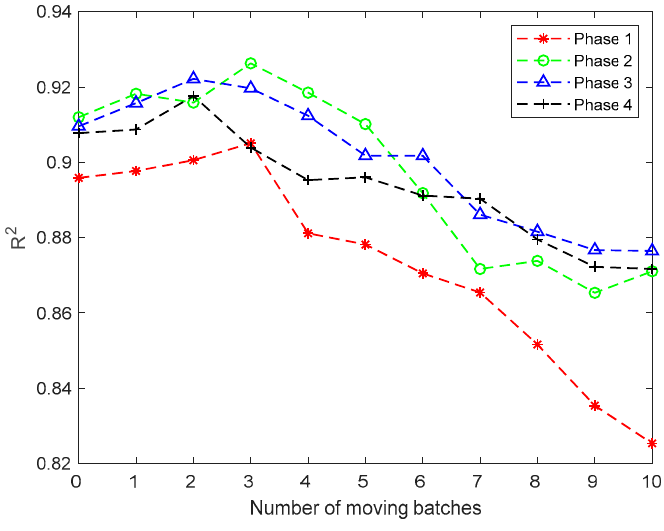
Figure 7. Results of mode 1. Table 3. Average